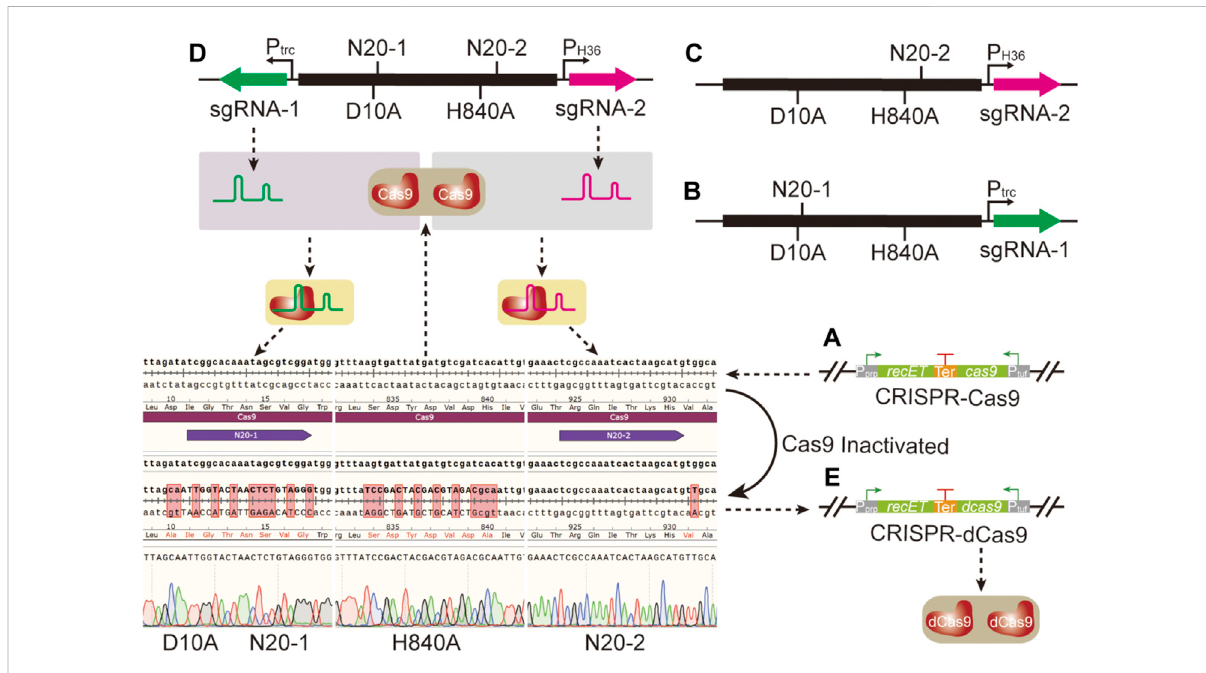
Site directed mutation of cas9 gene through CRISPR-Cas9 system. (A) The CRISPR-Cas9 system. (B) The plasmid pP trc sgRNA-dCas9; this plasmidwasusedtomutatethe10thaminoacidsitefromaspartatetoalanineofCas9. (C) TheplasmidpP H36 sgRNA-dCas9;thisplasmidwasusedto mutatethe840thaminoacidsitefromhistidinetoalanineofCas9. (D) TheplasmidpP trc P H36 sgRNA-dCas9;thisplasmidwasusedtomutatethe10th amino acid site from aspartate to alanine and 840th amino acid site from histidine to alanine of Cas9 simultaneously. (E) The CRISPR-dCas9